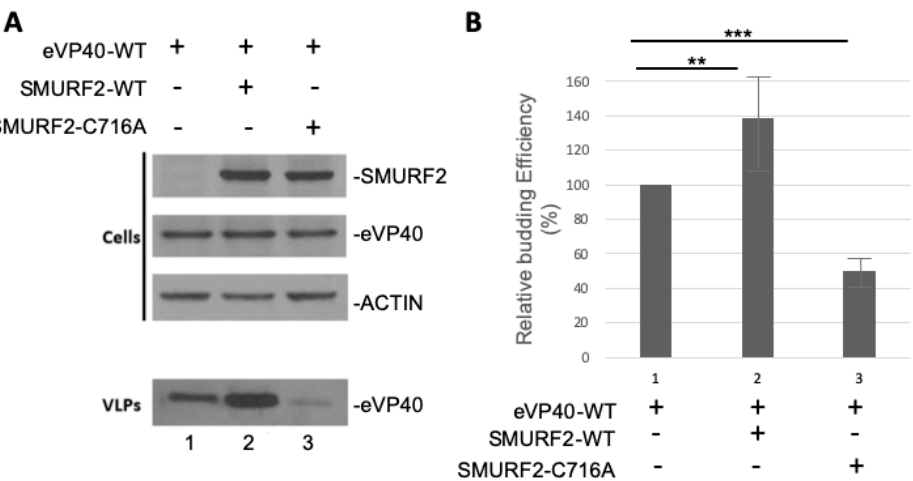
Figure 5. Enzymatically active SMURF2 positively regulates eVP40 VLP budding. ( A ) Representative Western blot of HEK293T cell extracts and VLPs of eVP40 alone (lane 1), eVP40 + SMURF2-WT (lane 2), and eVP40 + SMURF2-C716A mutant (lane 3). ( B ) Graph showing the relative budding efficiency of eVP40 VLPs under the indicated conditions from three independent experiments; student t test, ** = p <0.01, *** = p <0.005.